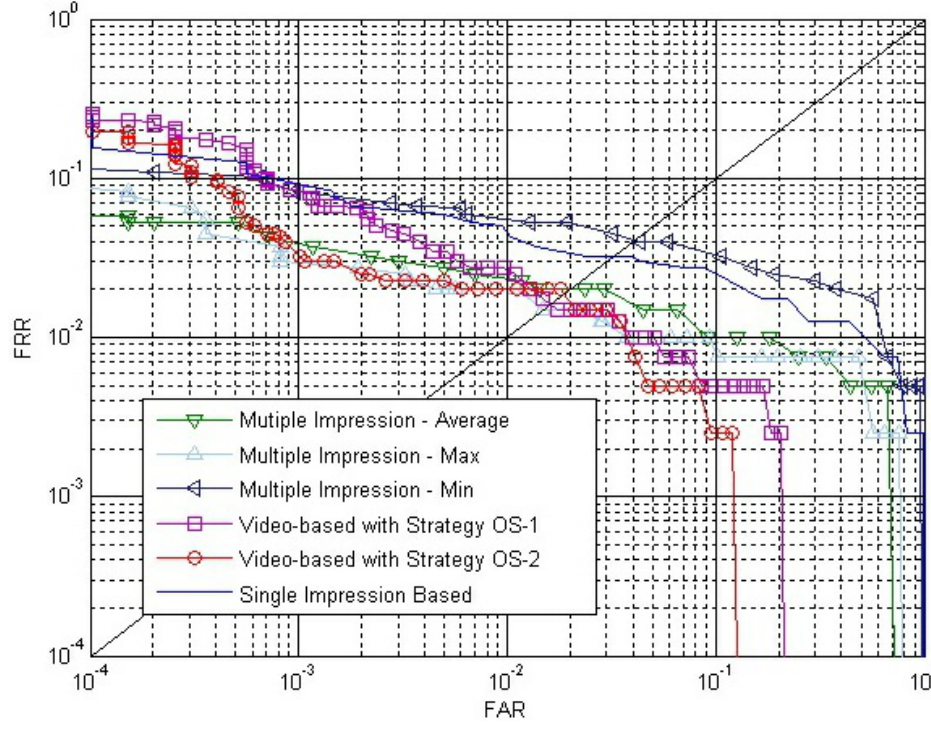
Figure 16. ROC of the single impression-based method, the multiple impressions fusion method and the proposed video-based